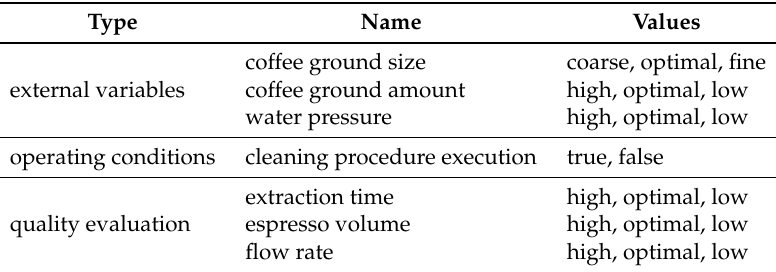
Table 1. Outline of dataset variables.